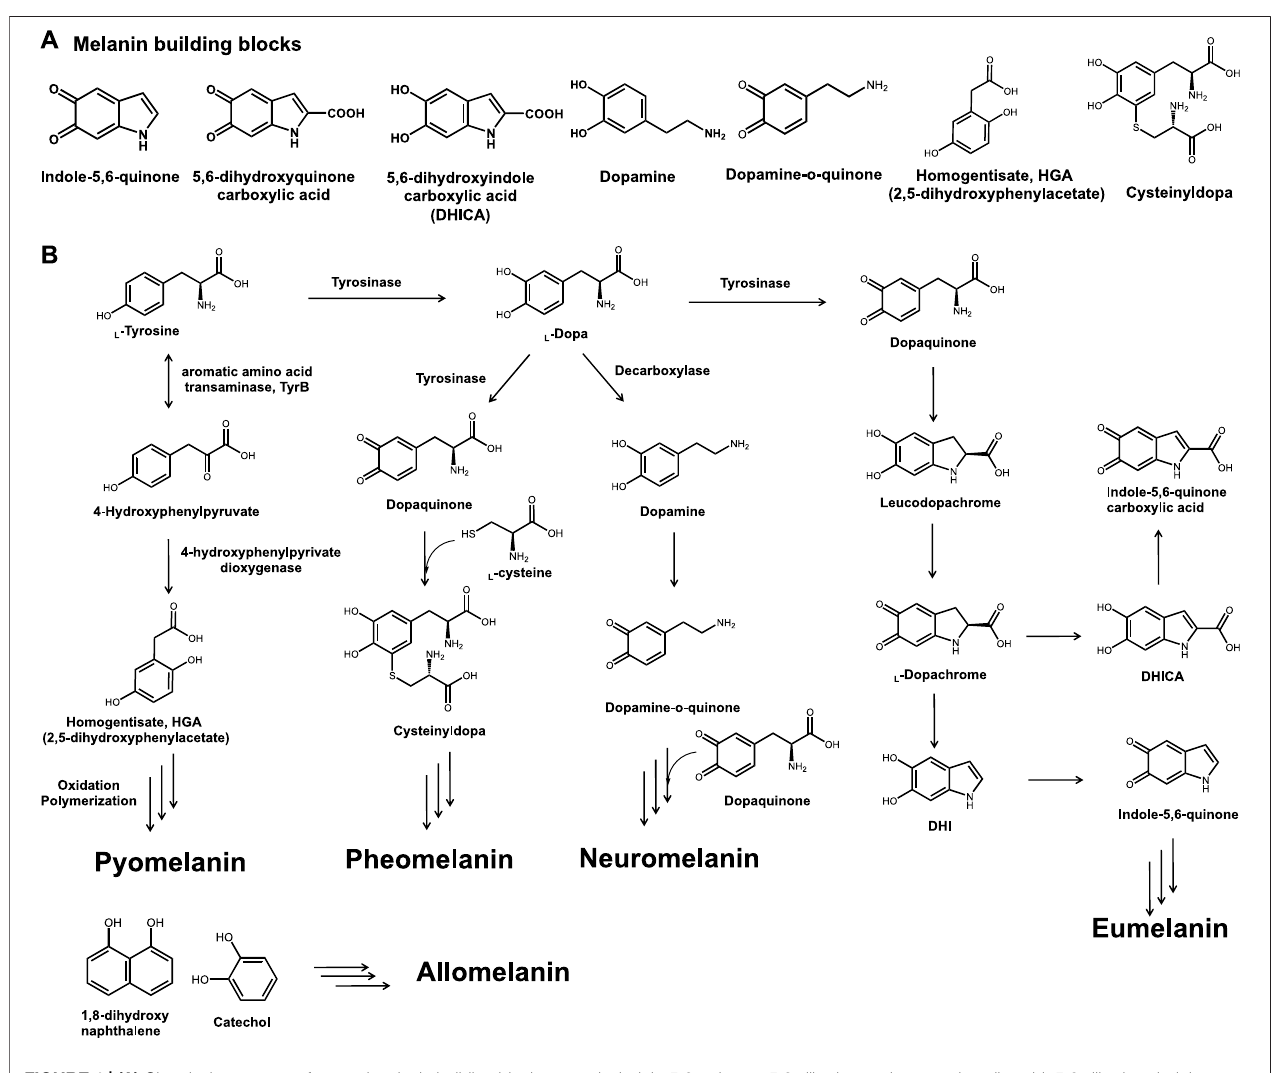
FIGURE 1 | (A) Chemical structures of general melanin building blocks, namely, indole-5,6-quinone, 5,6-dihydroxyquinone carboxylic acid, 5,6-dihydroxyindole carboxylic acid, dopamine, dopamine-o-quinone, homogentisate, and cysteinyldopa. (B) Types of bio-melanin and synthetic pathways.